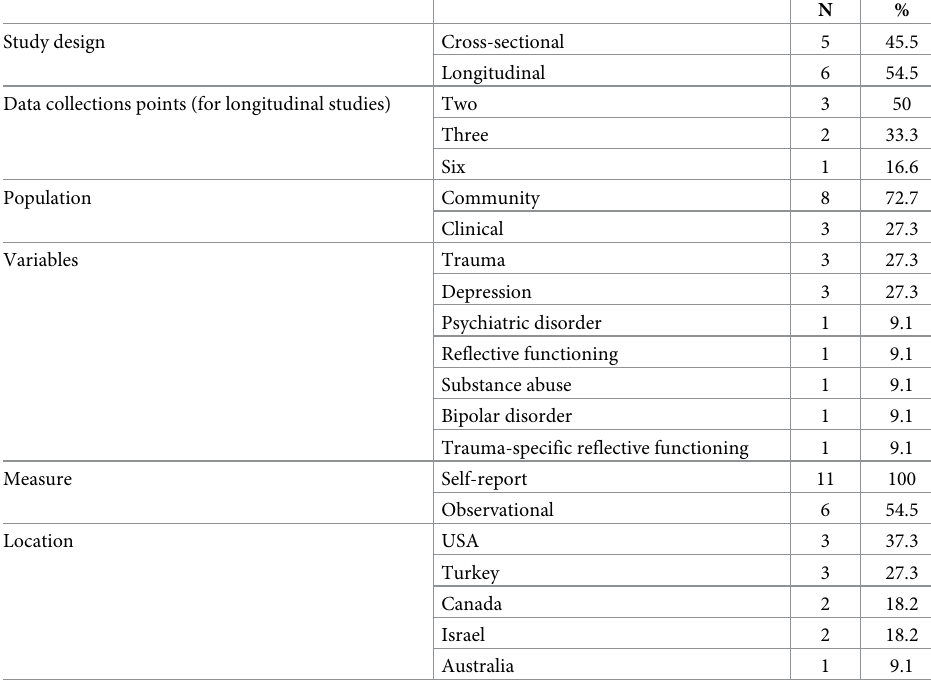
Table 2. Overview of the included